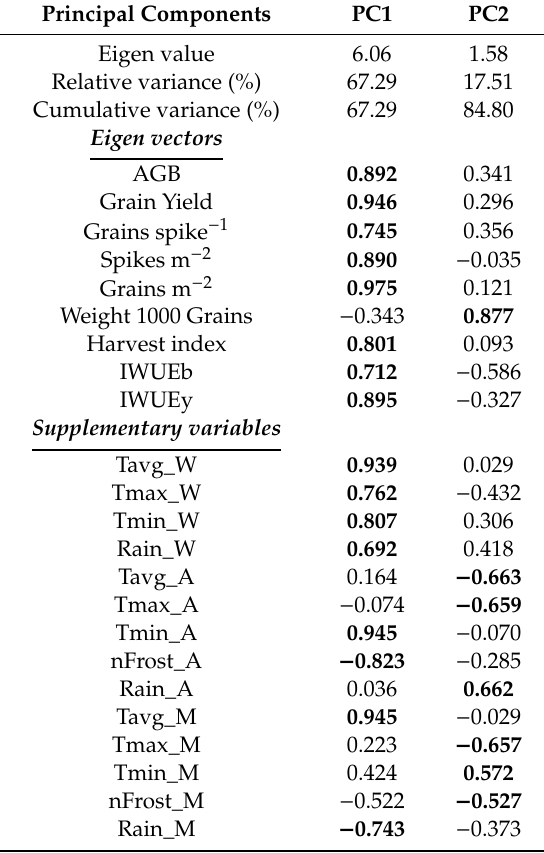
Table 9. Eigen values, relative and cumulative percentage of total variance, and correlation coe ffi cients for barley traits with respect to the two principal components (PC1 and